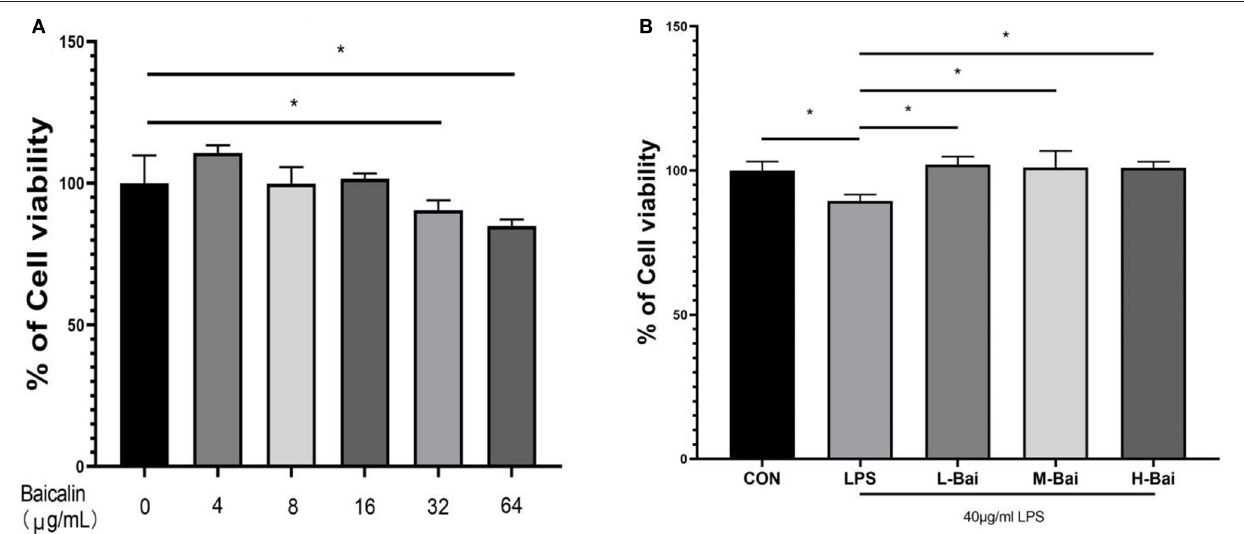
FIGURE 1 | Cytotoxicity of baicalin in IPEC-J2 cells and the effect of baicalin on the viability of IPEC-J2 cells stimulated with LPS. Baicalin at 4 µ g/mL increased the viability of IPEC-J2 cells, whereas 16 µ g/mL baicalin was not cytotoxic to IPEC-J2 cells. Meanwhile, baicalin at concentrations of ≥ 64 µ g/mL was significantly cytotoxic (A) . LPS stimulation decreased IPEC-J2 cell viability, and this effect alleviated by baicalin pretreatment (B) . Data are presented as the mean ± SEM ( n = 6 per treatment, * p < 0.05 compared to the model group). CON, control; L-Bai, low-concentration baicalin; M-Bai, middle-concentration baicalin; H-Bai, high-concentration